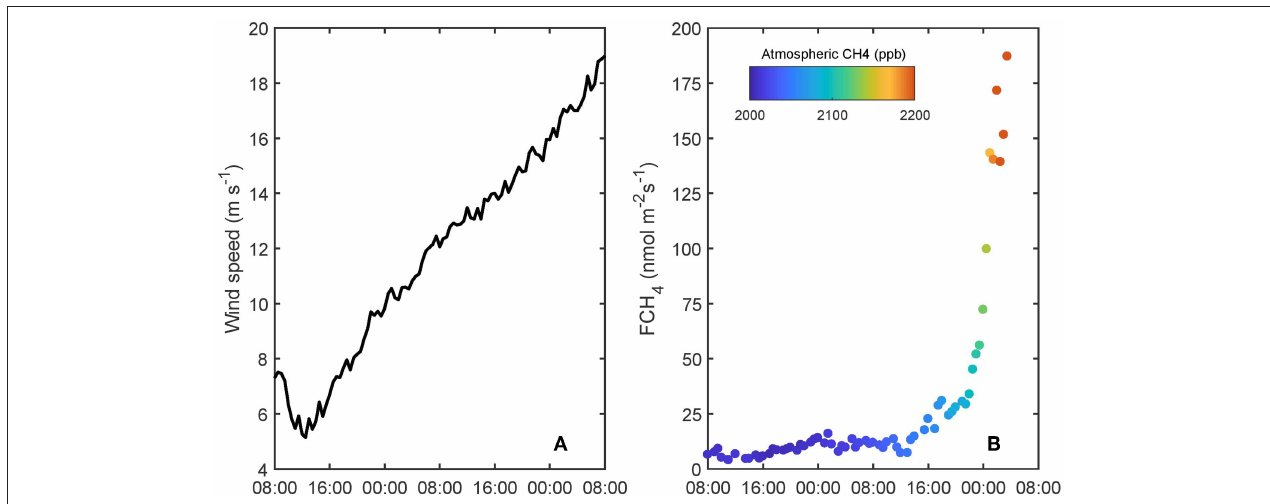
FIGURE 9 | (A) Wind speed, and (B) air–sea FCH 4 over a 48-h period during a high-wind speed event in January 14–16, 2018. The starting date is January 14 at 8:00 UTC, and the ending time is January 16 at 8:00 UTC.